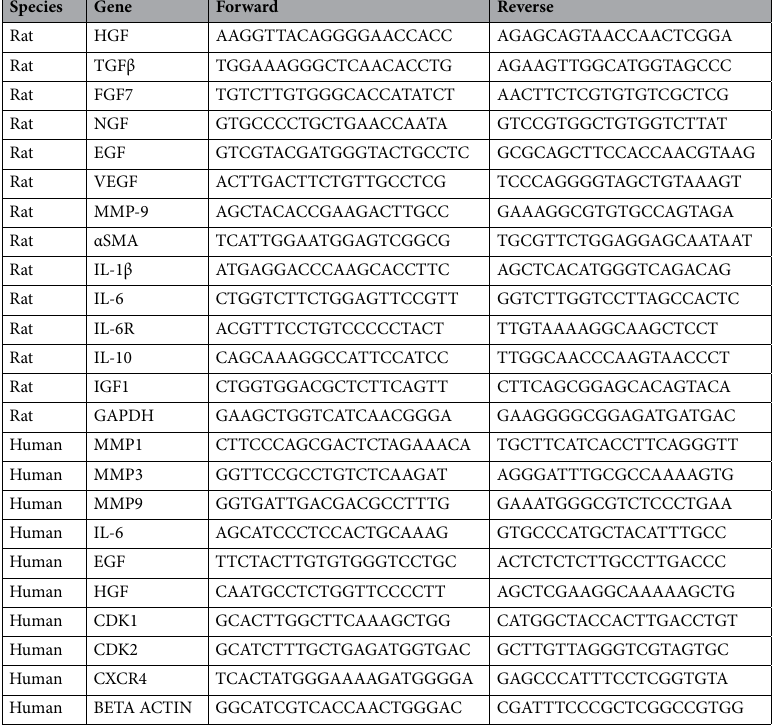
analysis. EGF, TGFβ1, and HGF proteins were analyzed by ELISA (HGF and EGF; R&D Systems, Minneapolis, USA; TGFβ1; Abcam, Cambridge, UK). A total of 100 μl of each of the pre-enrichment culture medium and standard solution for the protein was added to the wells coated with the primary antibody followed by reaction at 37 °C for 2 h. After the reaction was completed, the solution contained in the well was removed. Then, 100 μl of the secondary antibody (polyclonal antibody specific for mouse/rat EGF, TGFβ1, and HGF conjugated to horseradish peroxidase with preservatives) was added at 37 °C for one hour. After completion of the secondary antibody reaction, each well was washed three times, 90 μl of the substrate solution was added, and the reaction was carried out at room temperature for 30 min with light blocked. Each cytokine concentration was measured using a spectrophotometer (EMax; Molecular Devices) at 490 nm. Normal medium was used for baseline activ- ity comparisons. Quantitative real‑time polymerase chain reaction (Rt‑qpcR). The amount of mRNA expressed by rat ADSCs was determined according to the composition of the eight different media. P5 rat ADSCs at a density of 90% cultured on a 100-mm culture dish with each medium composition were washed twice using PBS and replaced with 5 ml of DMEM/F12 containing no serum or growth factors. Each medium collected after culturing for 24 h was used for mRNA extraction. Transforming growth factor β 1 (TGFβ1), vascular endothelial growth factor (VEGF), nerve growth factor (NGF), epidermal growth factor (EGF), interleukin-6 (IL-6), insulin-like growth factor (IGF-1), hepatocyte growth factor (HGF), fibroblast growth factor 7 (FGF7), matrix metallo-